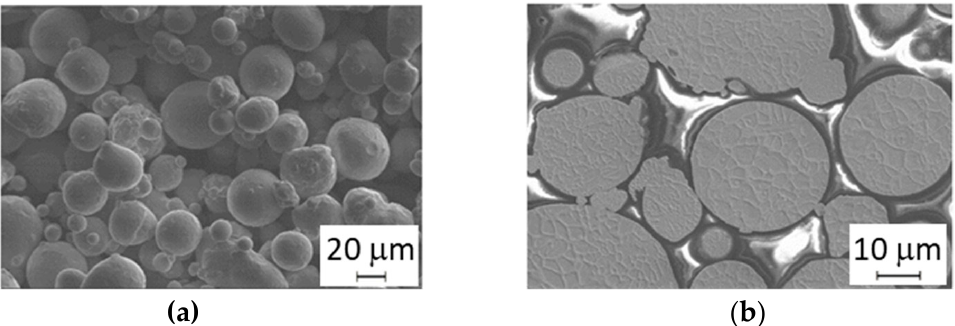
Figure 4. Scanning electron microscopy (SEM) images of powder MS1: ( a ) shape of powder grains; ( b ) cross ‐ section showing cellular microstructure.